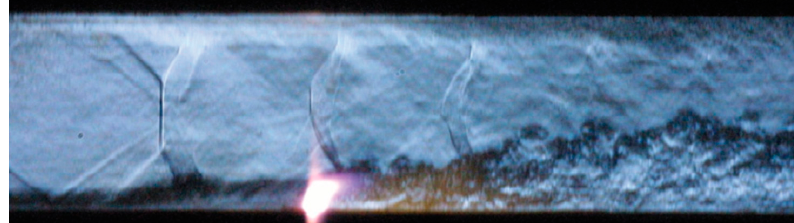
Figure 3. Schlieren photograph of plasma-assisted ignition in a straight duct: M = 2.5; fuel H 2 , plasma jet N 2 _50% + O 2 _50%, electric power 2.99 kW, adapted from [46]. Reprinted from [46] with permission from AIAA.